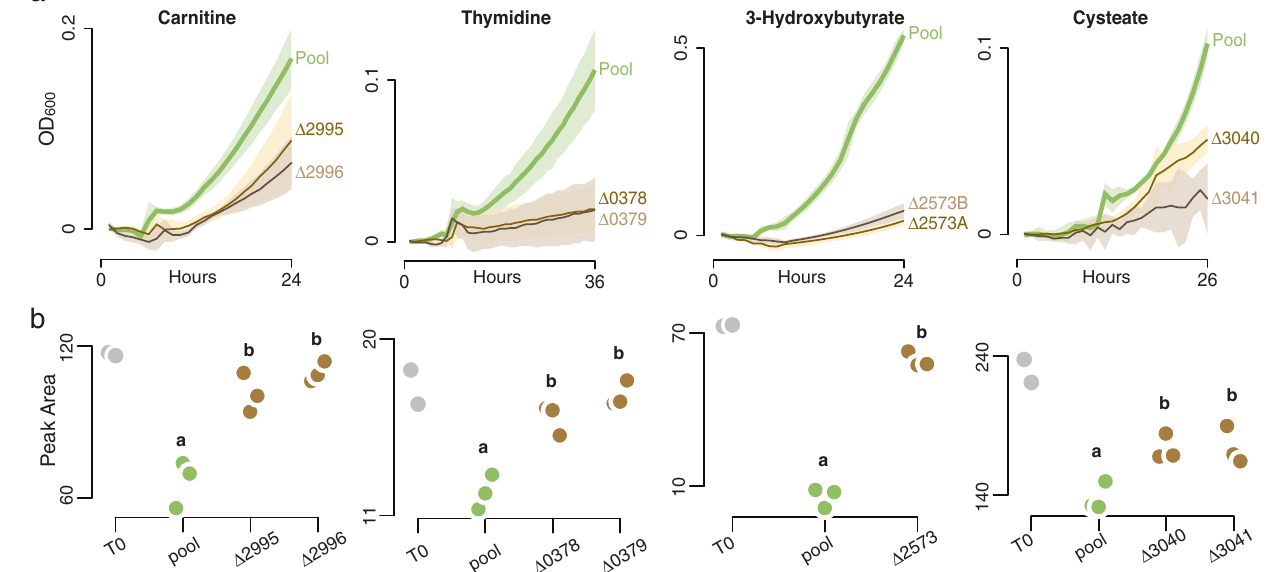
Fig. 2 Growth and metabolite drawdown results leading to four novel transporter annotations. a Growth of transporter mutants compared to growth of the pooled-RB-TnSeq library (an analog for wild-type growth but carrying transposon and resistance gene insertions) on selected marine plankton metabolites. Shaded regions indicate 95% con fi dence intervals ( n = 4). Numbers refer to Ruegeria pomeroy i DSS-3 locus tags. b Substrate concentrations ( 1 H-NMR peak area) after growth of mutants (brown symbols, n = 3) or the pooled-RB-TnSeq library (green symbols, n = 3), and at inoculation (gray symbols, n = 2). Letters that differ indicate that peak areas for the mutants were signi fi cantly higher than for the pooled-RB-TnSeq library (ANOVA, n = 3, p ≤ 0.05), with a TukeyHSD test carried out when multiple mutants for the same substrate were tested ( p ≤ 0.05). For full results, see Table